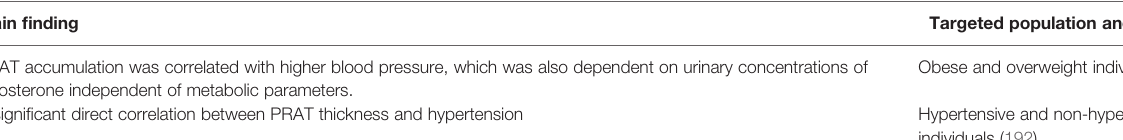
TABLE 2 | Main fi ndings of studies linking perirenal adipose tissue to cardiovascular